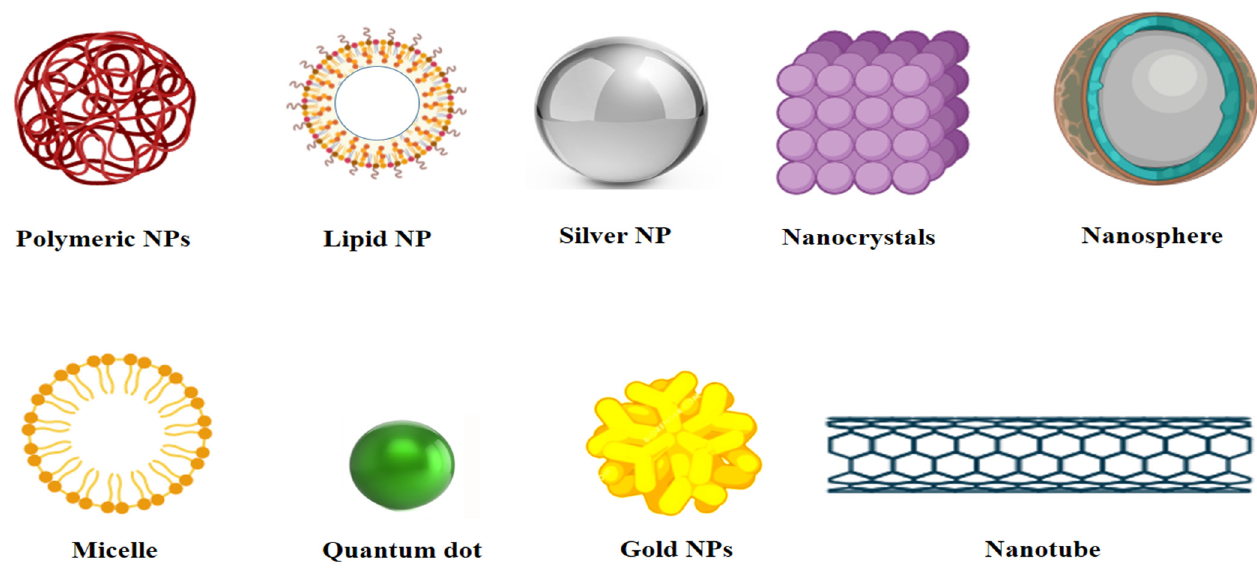
Figure 2. Different classes of nanoparticles. NPs: nanoparticles (created using biorender.com) (accessed on 28 September